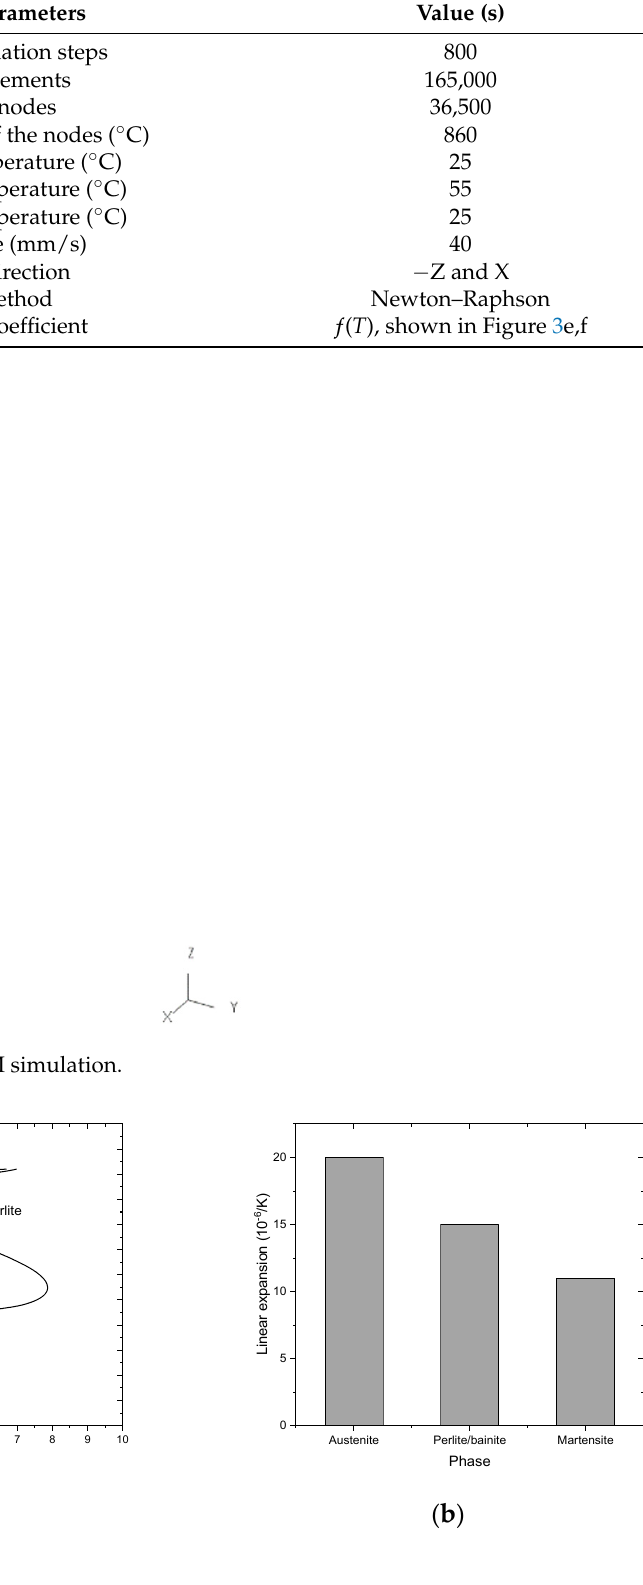
( f ) Figure 3. Thermophysical properties for AISI 4340 steel used in FEM simulation: ( a ) TTT diagram [37]; ( b ) thermal expansion [38]; ( c ) Young´s modulus and Poisson’s ratio [38]; ( d ) thermal conductivity [38]; ( e ) HTC (oil) adapted with permission from [39] 2022, Elsevier; and ( f ) HTC (water) [40]. 4. Results and Discussion 4.1. Thermal Analysis In Figure 4, the experimental results of the temperature evolution during the cooling on the surface of the quenched parts from 860 °C until reaching the quenching media temperature are shown; oil and water with temperatures of 55° and 25°, respectively, in the two directions of immersion, vertical and horizontal.